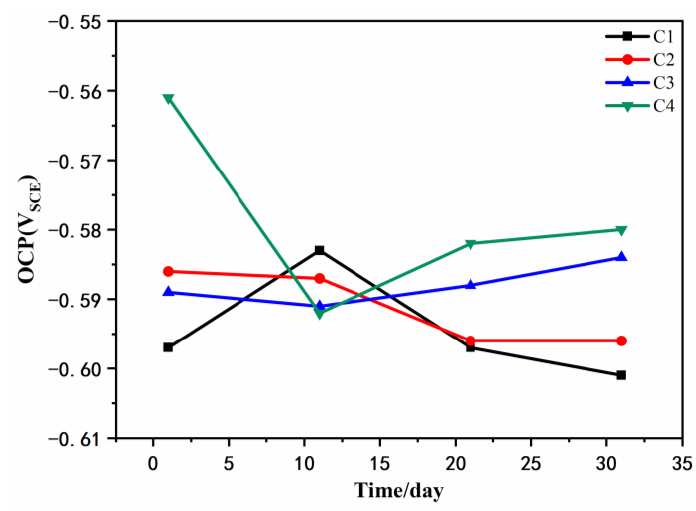
Figure 3. Open circuit potential of coatings after immersion.